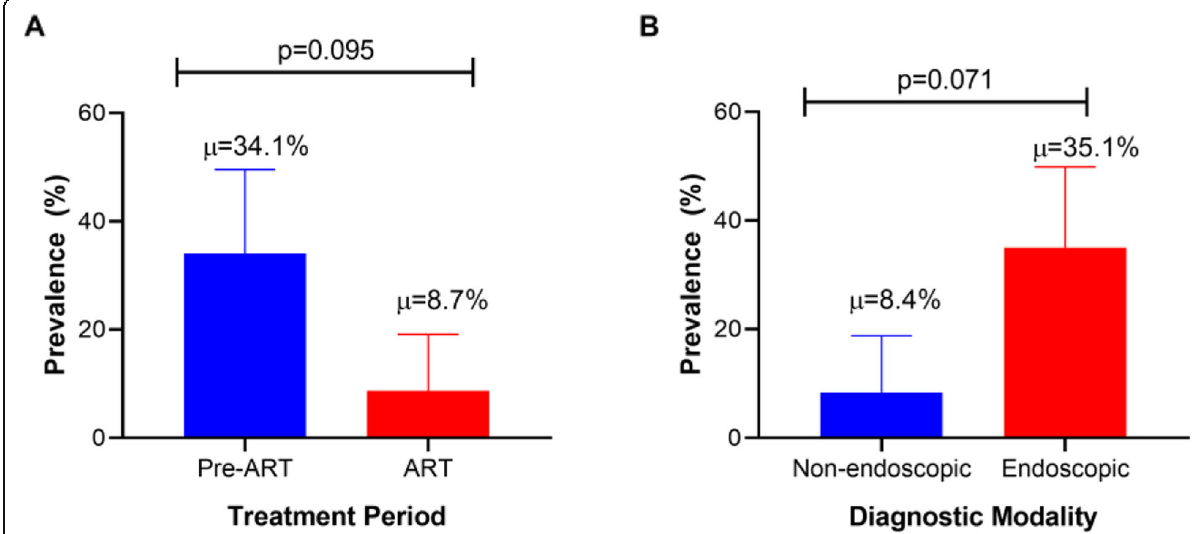
Fig. 6 Mean prevalence of HIV-associated esophageal candidiasis by antiretroviral therapy era ( a ) and diagnostic modality ( b )